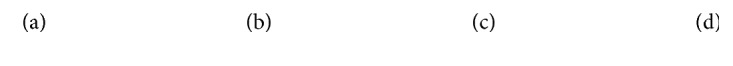
Effect of Rhus verniciflua extract (RVE) on the expression of FcεRI signaling pathway-related genes in RBL-2H3 mast cells. (a) Histamine levels in the culture medium of IgE-sensitized RBL-2H3 mast cells treated with RVE. (b, c) Immunoblot analysis performed with anti-p-Syk, -p-Lyn, -p-Fyn, -p-PLCγ1, -p-Akt, and -p-ERK antibodies. α-Tubulin was used as the protein loading control. Results are expressed as mean ± SE of at least five independent experimental results that were tested by analysis of variance with Bonferroni's post hoc testing; #p < 0.005, ##p < 0.005, and ###p < 0.0005 versus the control group; ∗p < 0.05, ∗∗p < 0.005, and ∗∗∗p < 0.0005 versus the DNP-HSA-treated group.